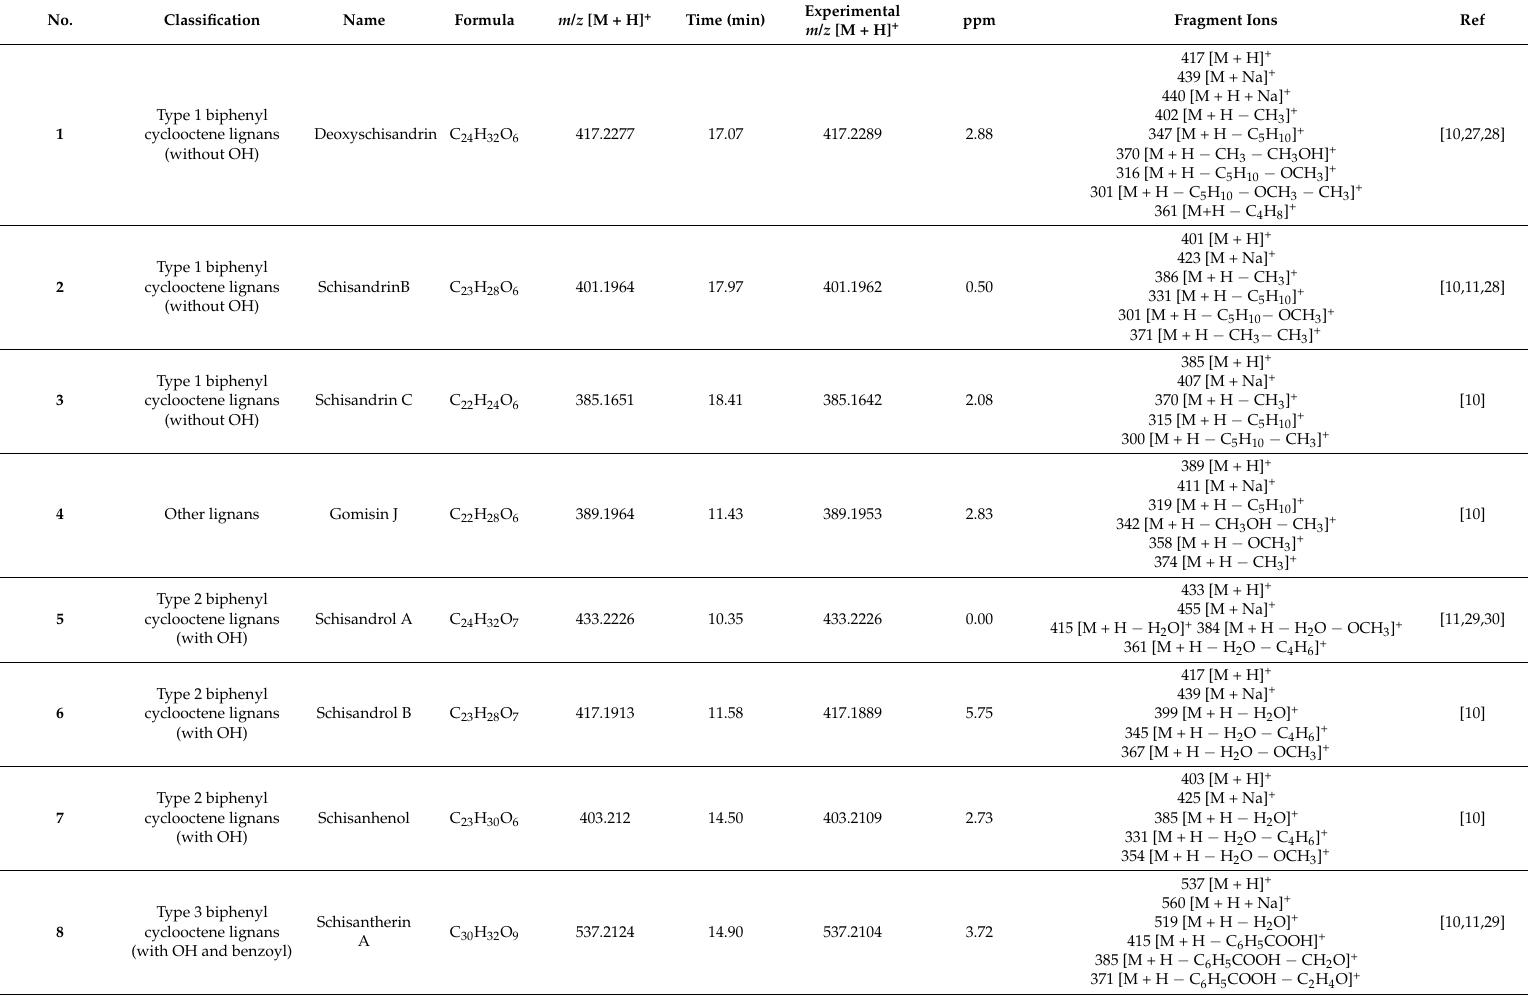
Table 2. Identification of the chemical constituents of the WWZ extract by using UPLC-Q-TOF/MS in positive ion